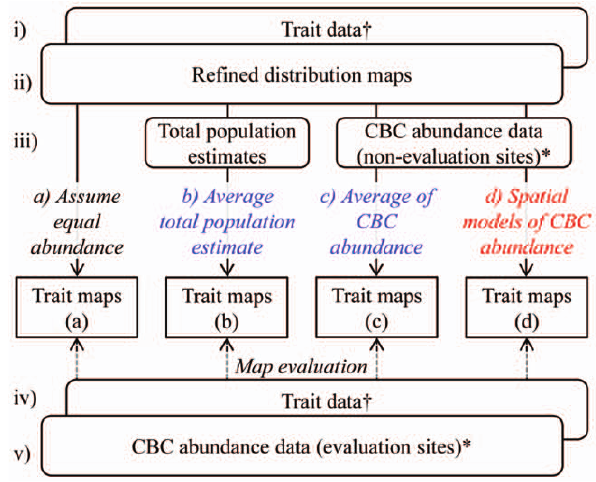
Figure 2. The basic scheme for generating and evaluating maps of the trait composition of bird communities. The maps were generated by combining i) trait data, ii) refined distribution maps and iii) various types of abundance data. We used four estimates of abundance (a–d) for generating the maps, based on three basic assumptions about the abundance of bird species: 1) that all species have an equal abundance (of one) in all grid cells (black text); 2) that species differ in abundance from one another, but with no spatial variation in abundance within species (blue text); and 3) that abundance varies both among species and spatially (red text). The maps were evaluated using iv) trait data and v) local abundance data from the Christmas Bird Count sites. Note (*) that the abundance data from the CBC sites were divided into a set for generating the maps (2398 sites) and a set for evaluating the resulting maps (68 sites). Note also ( { ) that the same trait data were used for generating and evaluating the